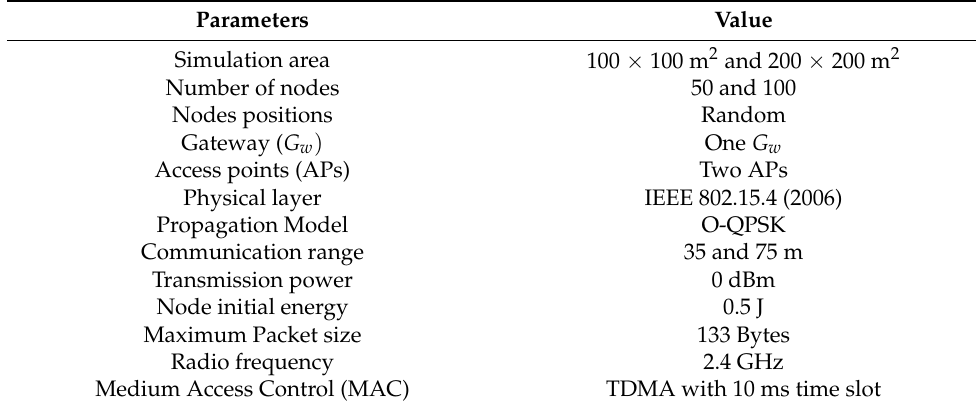
Figure 3. A network topology example with 50 sensor nodes. Table 1. System Parameters.